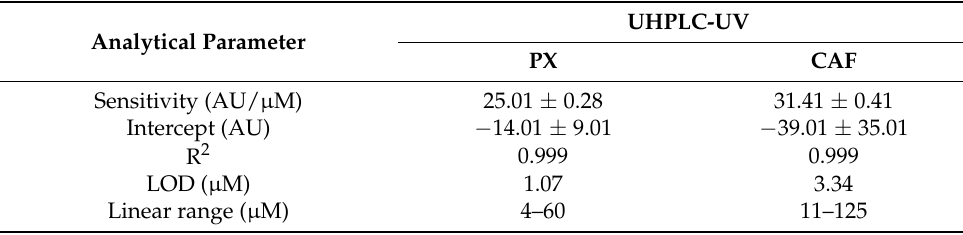
Table 2. Analytical parameters for the simultaneous quantification of paraxanthine (PX) and caffeine (CAF) in spiked saliva by